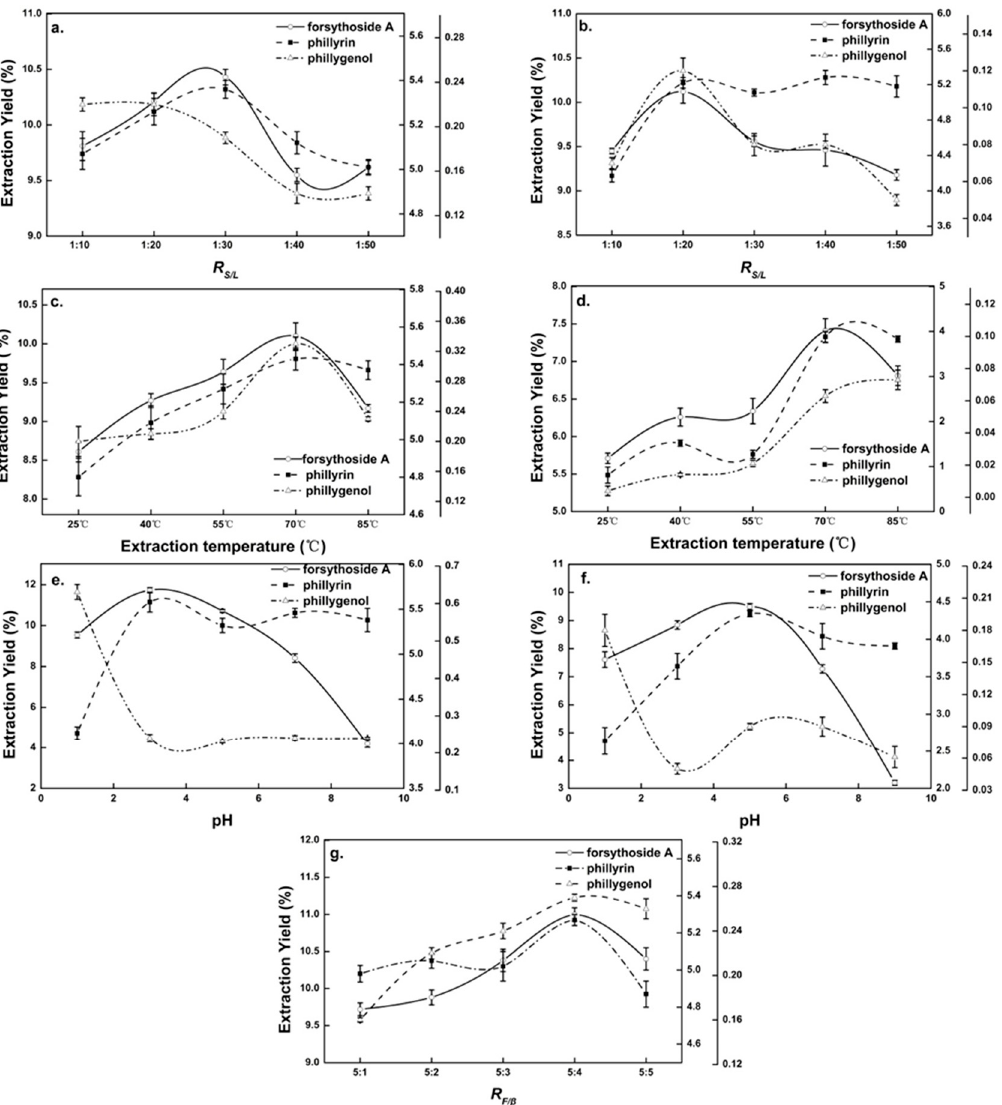
Figure 2. Single-factor diagram of β -CD-assisted extraction and pure-water extraction. Effects of ( a ) solid–liquid ratio (R S/L ) on β -CD-assisted extraction, ( b ) R S/L on pure-water extraction, ( c ) extraction temperature on β -CD-assisted extraction, ( d ) extraction temperature on pure-water extraction, ( e ) extraction pH on β -CD-assisted extraction, ( f ) extraction pH on pure-water extraction and ( g ) β -CD and Forsythia suspensa leaf ratio (R F/ β ) on β -CD-assisted extraction.